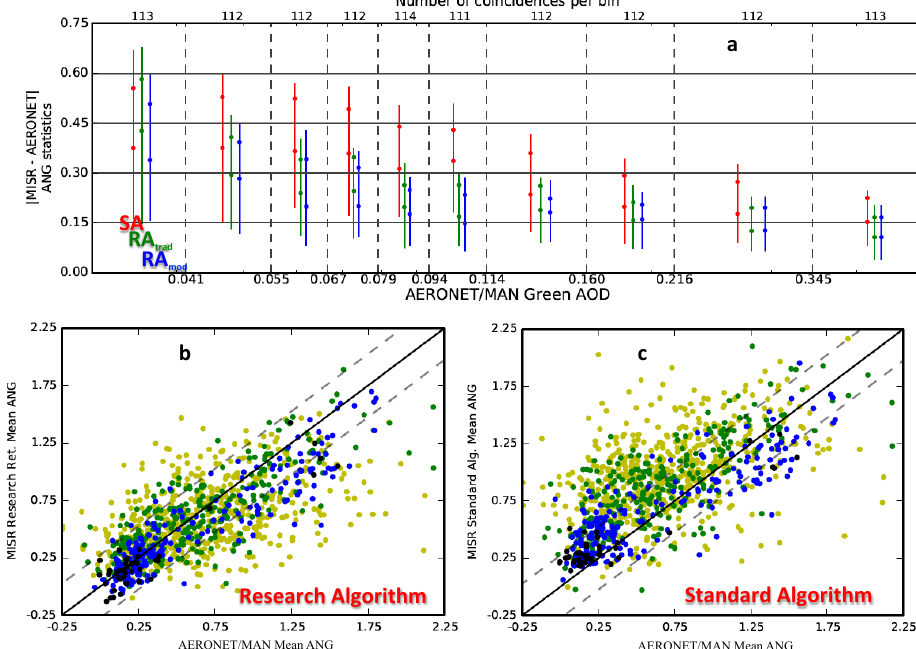
Figure"10" Figure 10. Panel (a) shows the statistics of the | MISR-MAN/AERONET | Ångström Exponent coincidences, conditioned on 558nm AERONET/MAN AOD. The first line of the triplets shows the SA-AERONET/MAN comparison, the second line shows the comparison between the RA and MISR-MAN/AERONET with the standard χ 2 criterion applied, and the 3rd line shows the comparison between the abs RA and MISR-MAN/AERONET with the modified χ 2 criterion. The vertical lines represent the 25th–75th percentiles, the lower dot rep- abs resents the median absolute error and the upper dot represents the 68th percentile value. The number of coincidences per AOD bin is listed at the top of the plot. The upper limit of each green-band AOD bin (binning is done based on green band AOD) is shown at the bottom (except for the last AOD bin, which includes all higher AOD cases). Panels (b) and (c) show the MISR-AERONET/MAN ANG cases for all AOD>0.01, for the research algorithm (all modifications with updated χ 2 criterion) and standard algorithm, respectively. Yellow dots abs correspond to points with AERONET AOD less than 0.10, green dots represent AOD between 0.10 and 0.20, blue dots indicate AOD between 0.20 and 0.50, and black dots designate AOD values greater than 0.50. Statistics for the ANG plots are presented in Table